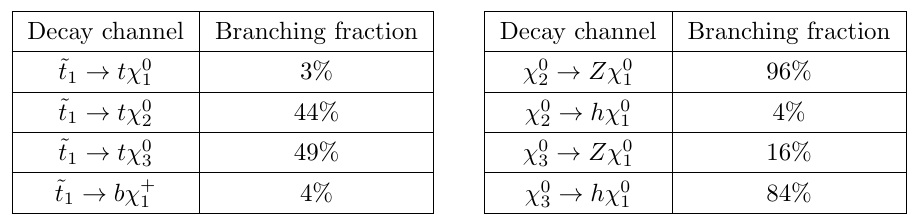
Table 2 . The decay branching fractions of ~ t 1 , (cid:31) 0 (cid:31) (cid:6) 100% decays to W (cid:6) (cid:31) 0 1